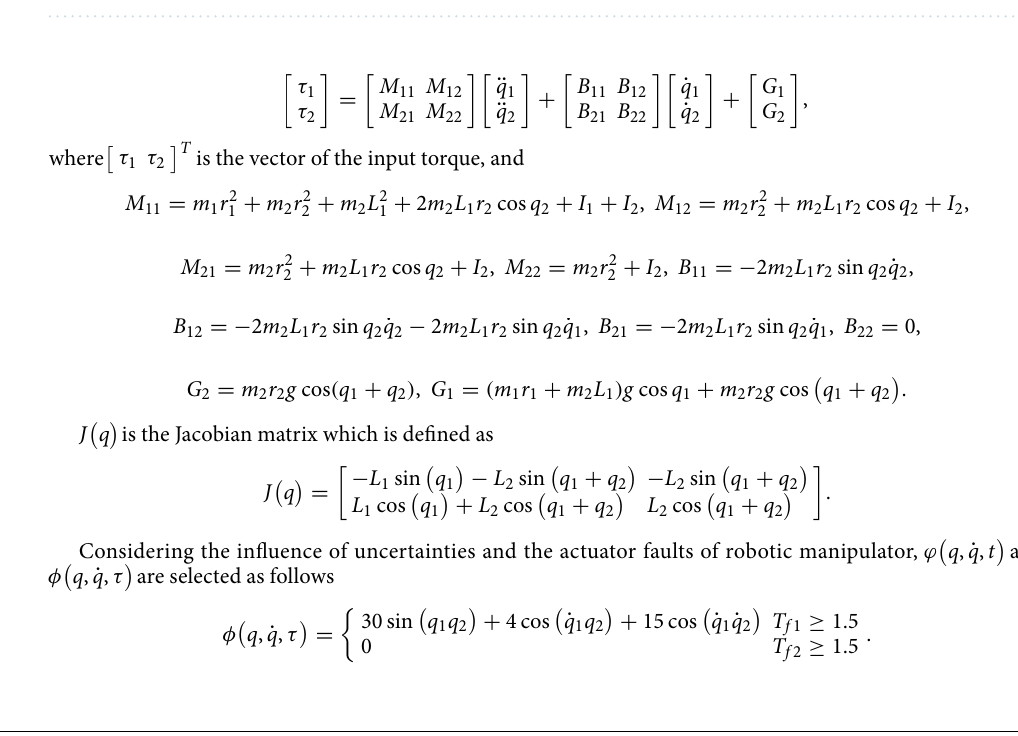
Figure 4. Structure of robot manipulator with